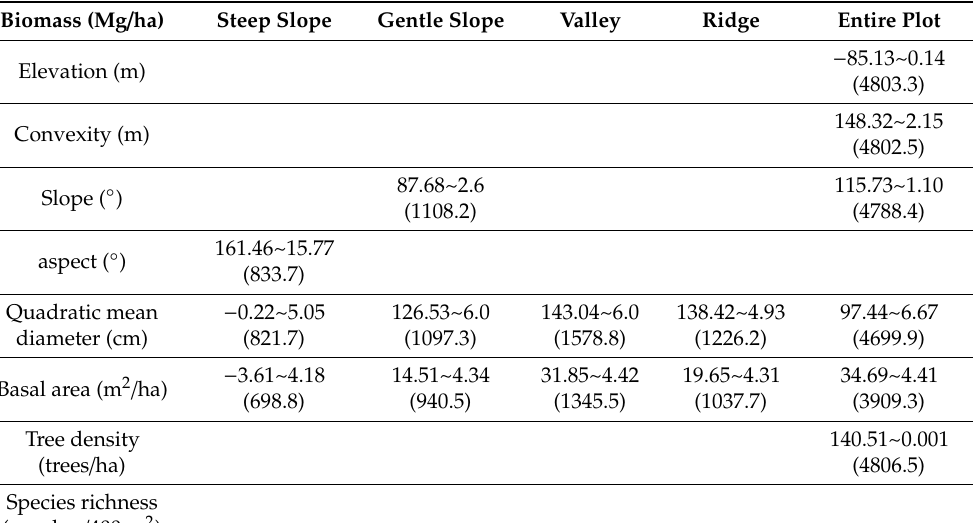
Table 4. The relationships between biomass and environment and forest structure variables including elevation, convexity, slope, aspect, quadratic mean diameter, basal area, tree density, and species richness *. Biomass (Mg / ha) Steep Slope Gentle Slope Valley